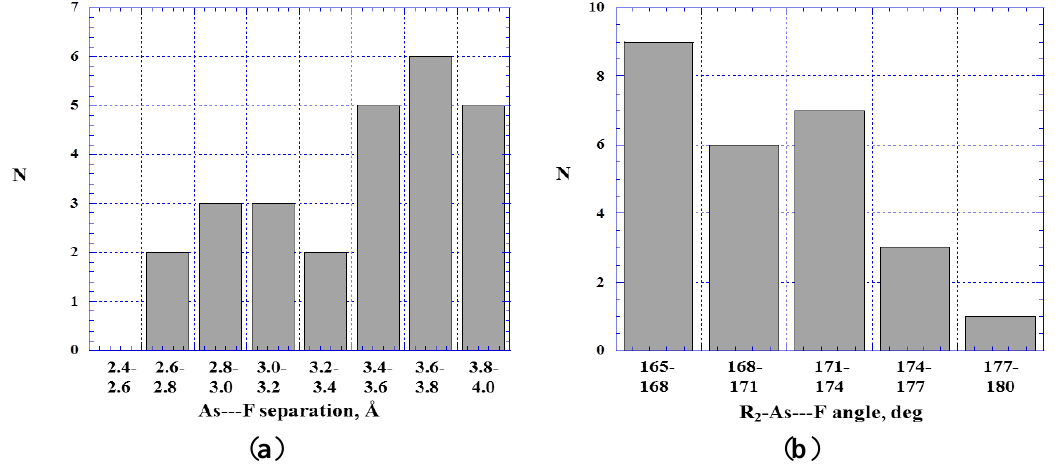
Figure 12. Histograms showing numbers N of R separations ( a ) and R –As---F angles ( b 2